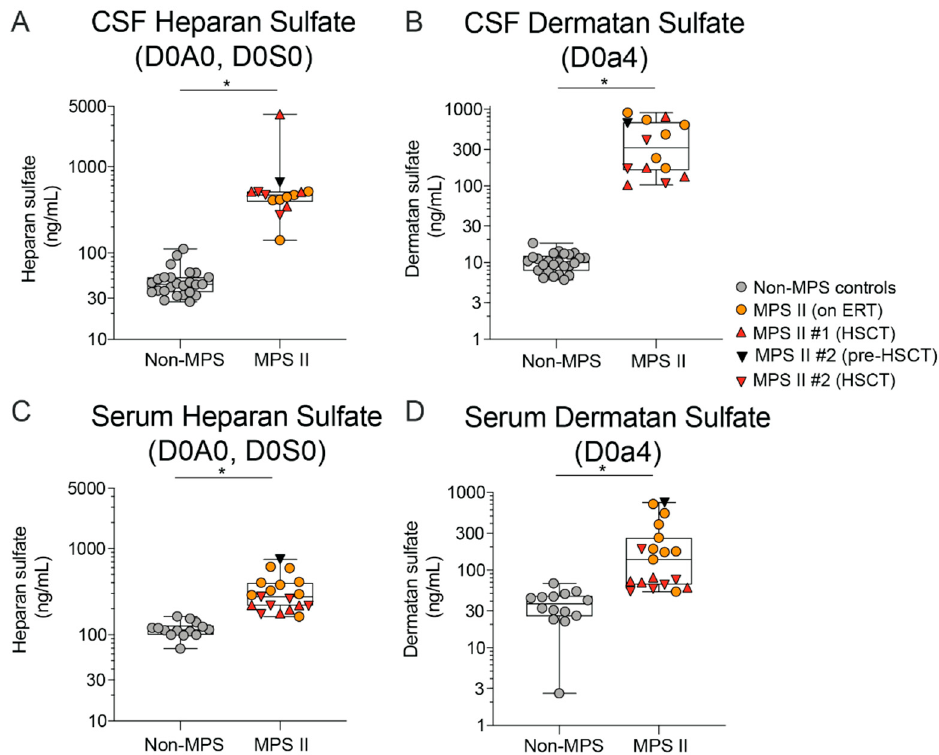
Figure 4. Accumulation of Heparan and Dermatan sulfate derived disaccharides in CSF and serum of MPS II patients. CSF HS ( A ) and DS ( B ) levels in MPS II patients who were either untreated at the time of sample collection ( n = 1), on ERT ( n = 6), or on HSCT ( n = 2) were compared to age-matched controls ( n = 25); serum HS (C) and DS (D) levels in MPS II patients who were either untreated at the time of sample collection ( n = 1), on ERT ( n = 9), or on HSCT ( n = 2) were compared to age-matched controls. One outlier each from serum HS and serum DS (different samples) was omitted based on the Wilcoxon sum rank test [41]. Each data point represents a single control or patient visit. Data are plotted using a min to max box plot. Differences between MPS II and non-MPS controls are estimated using a linear mixed-effects model to account for repeated measures in 2 patients. No evidence of age or treatment is seen in the MPS II sample set, and thus the model will not specifically adjust for these in the estimation; * p <